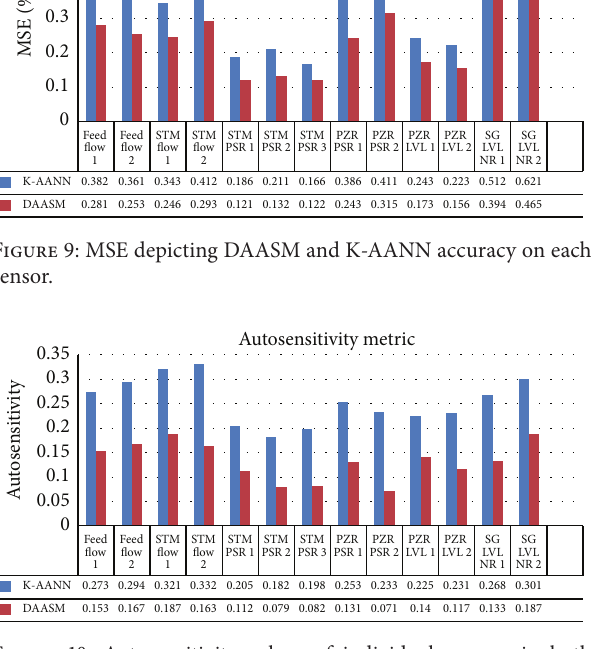
Figure 10: Autosensitivity values of individual sensors in both